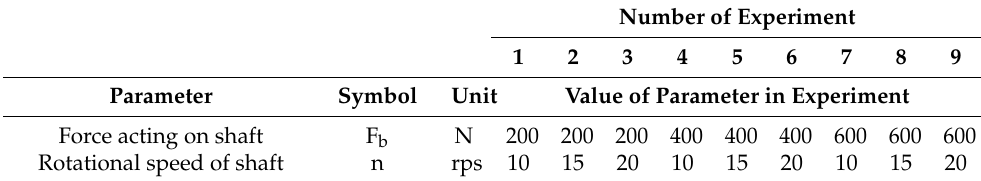
Table 3. Conditions of laboratory experiments.